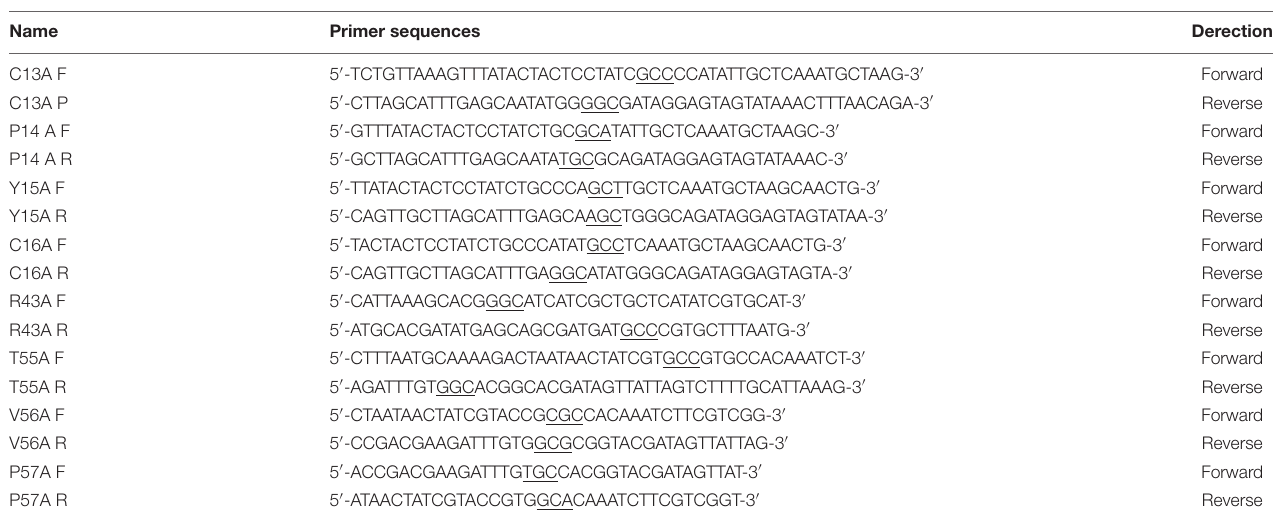
TABLE 1 | Primer for Ps-Grx3 mutant